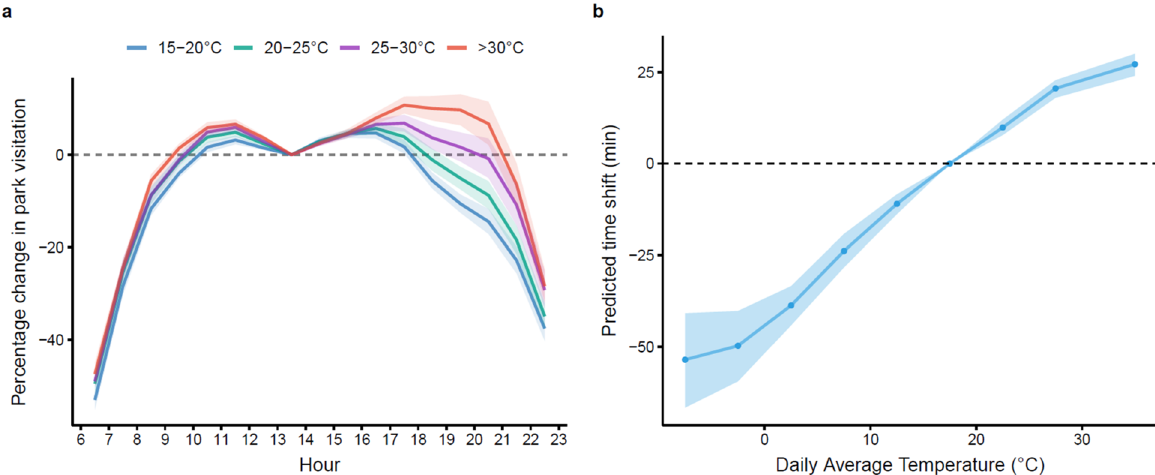
Figure 4. Quantification of temperature-driven time shift. ( a ) Within-day hourly activity distribution by daily average temperature range. Each line represents the within-day activity pattern for days lying in each daily average temperature range. Shaded areas are 95% confidence intervals. ( b ) Quantified time shift (Δ t ) as a function of daily average temperature. Shaded areas are 95% confidence intervals calculated through Monte Carlo sampling of econometric parameter estimates of both the within-day activity distribution pattern (25 quantiles) and the daily activity quantity by temperature (25 quantiles) 54